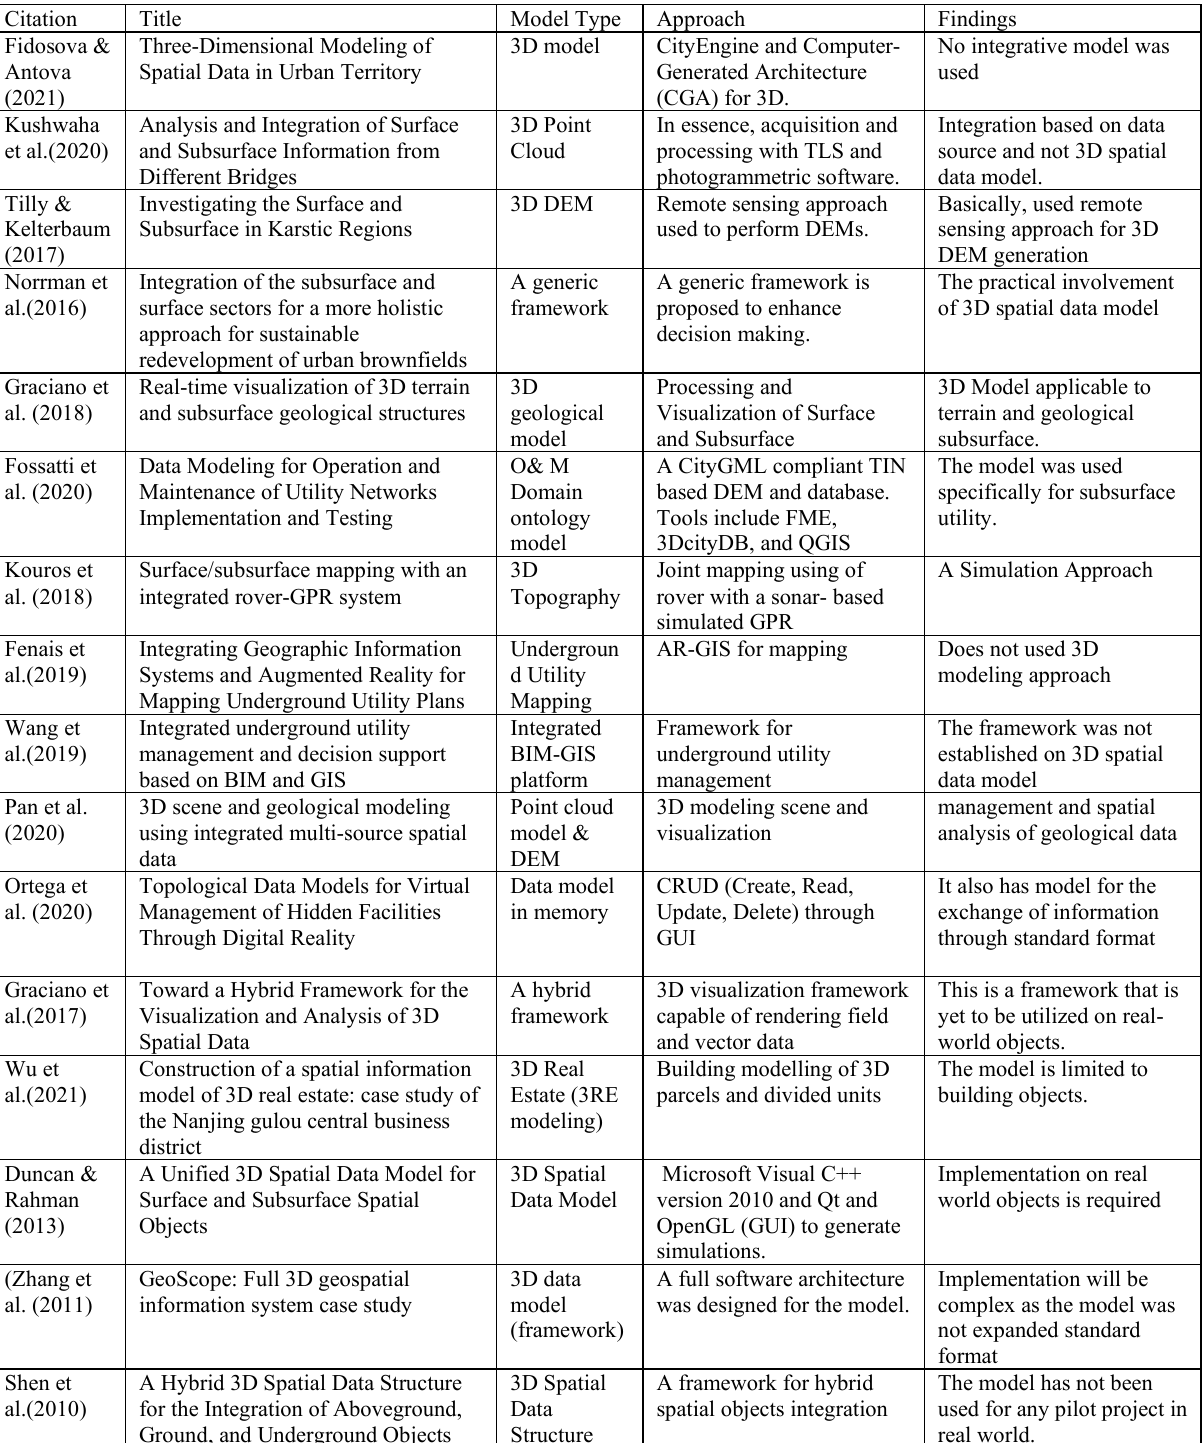
Table 1. 3D Representation of Surface and Subsurface Spatial